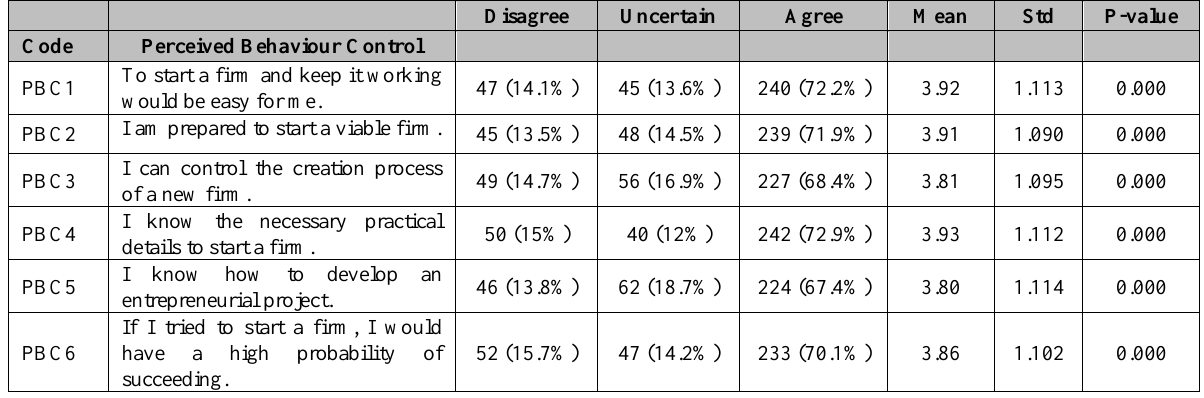
Table 5. Frequency Distribution of Perceived Behaviour Control Towards Entrepreneurship Disagree Uncertain Agree Mean Std P-value